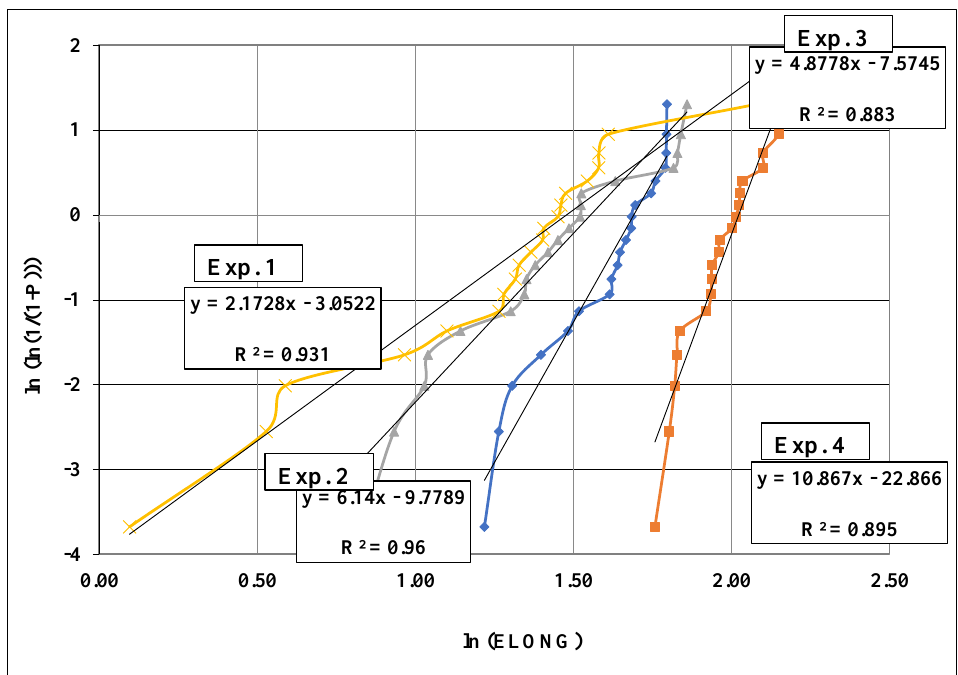
Figure 3. Weibull distribution of % elongation of Al – 7 Si – 0.3 Mg alloy for different experiments itemised in Table 1.